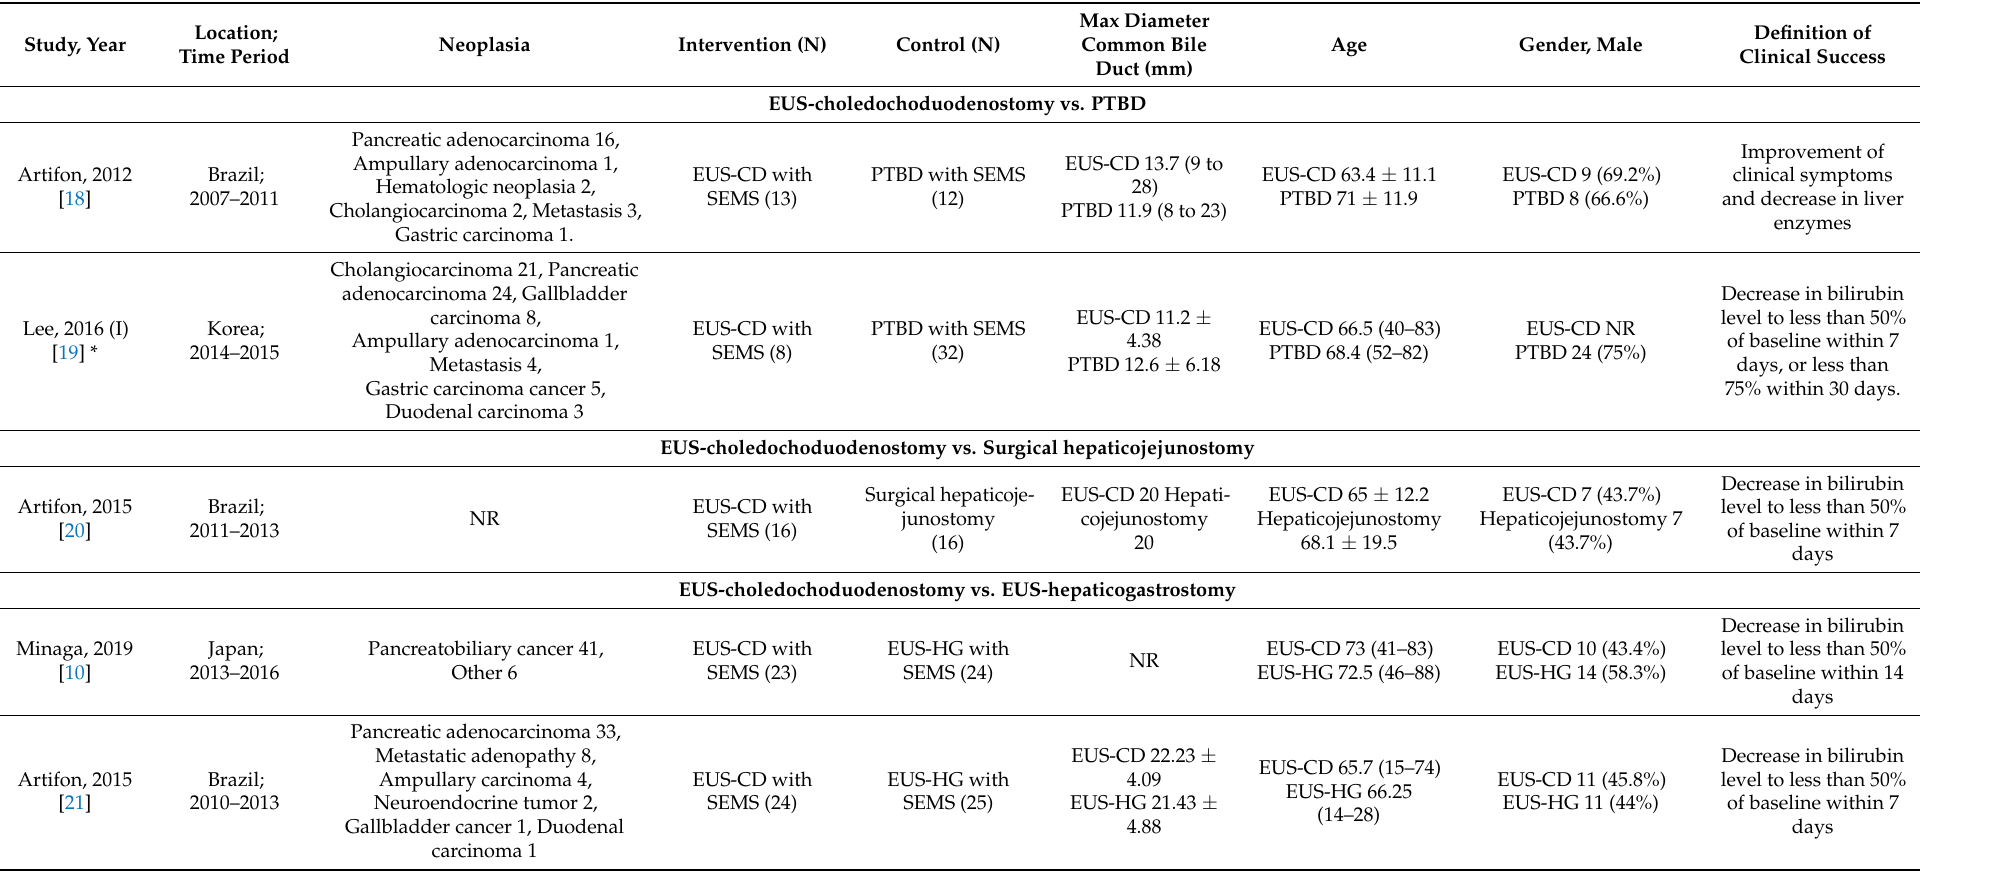
Table 1. Baseline characteristics of the included